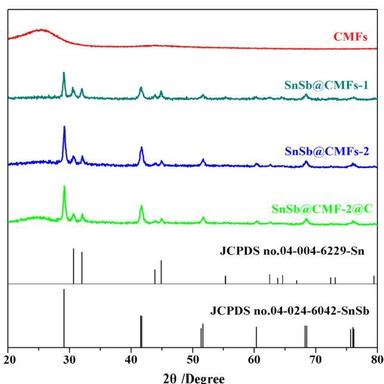
XRD patterns of SnSb@CMFs-1, SnSb@CMFs-2, SnSb@CMF-2@C and CMFs.